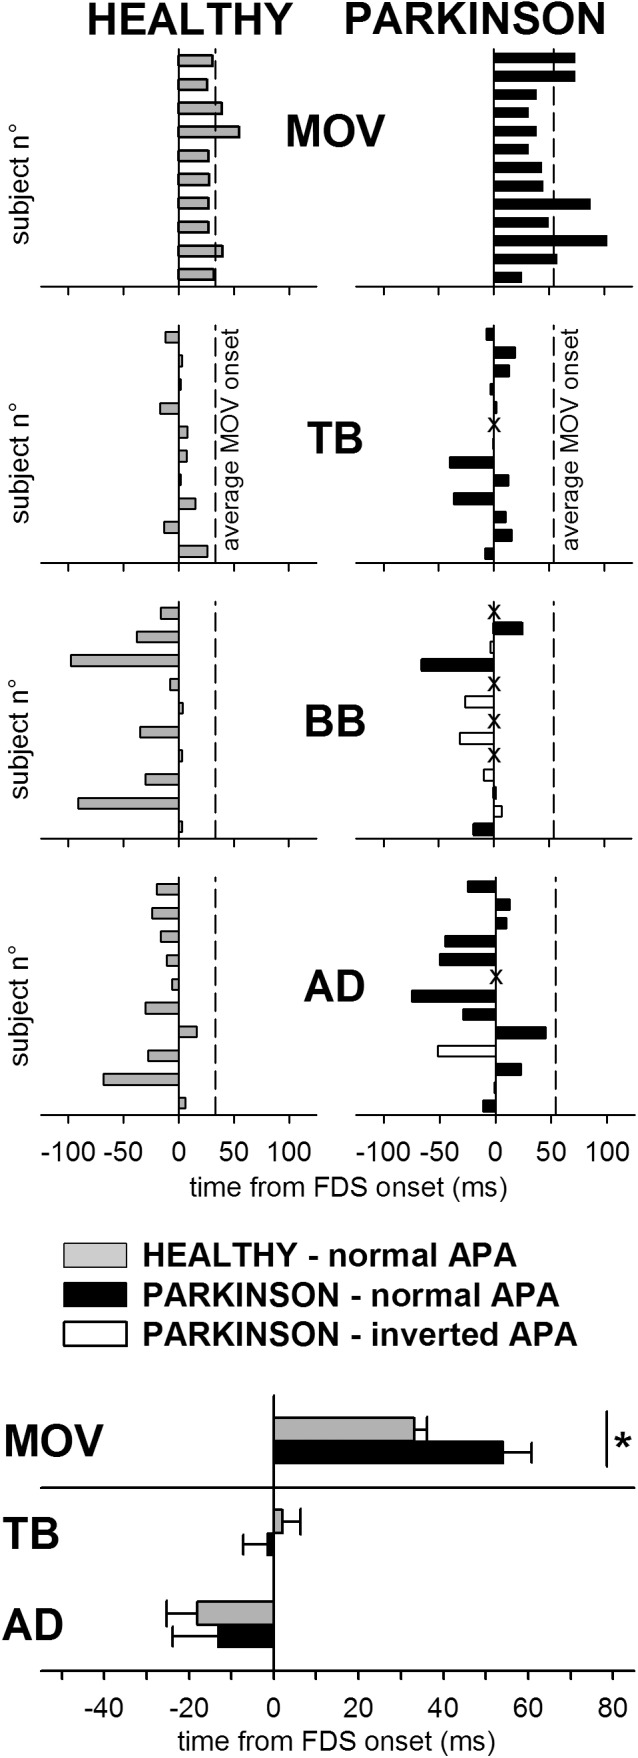
Comparison of the intra-limb APA chain in healthy subjects (HEALTHY) and PD patients (PARKINSON). Latencies of finger flexion (MOV) and intra-limb APAs in TB, BB, and AD are plotted with respect to onset of FDS. Each single participant is represented in the upper panels, where dashed lines mark the average movement latency for either group of participants. (For PD patients, latencies of intra-limb APAs which had the same sign observed in all healthy individuals (excitatory in TB and inhibitory in BB and AD) are plotted by black bars, latencies of intra-limb APAs of inverted sign are plotted by white bars and lack of intra-limb APAs is marked by “X.” Note that in several patients intra-limb APAs in BB were lacking or even inverted. The lowermost panel shows, for both groups, the mean latency (±SE) of the onset of finger flexion and of the intra-limb APAs in TB and AD, excluding data from those PD patients in which the APA was lacking or inverted. The asterisk marks the significant difference. The BB muscle was excluded from the latency comparison because only four patients had an APA of the same sign normally observed in healthy subjects.)